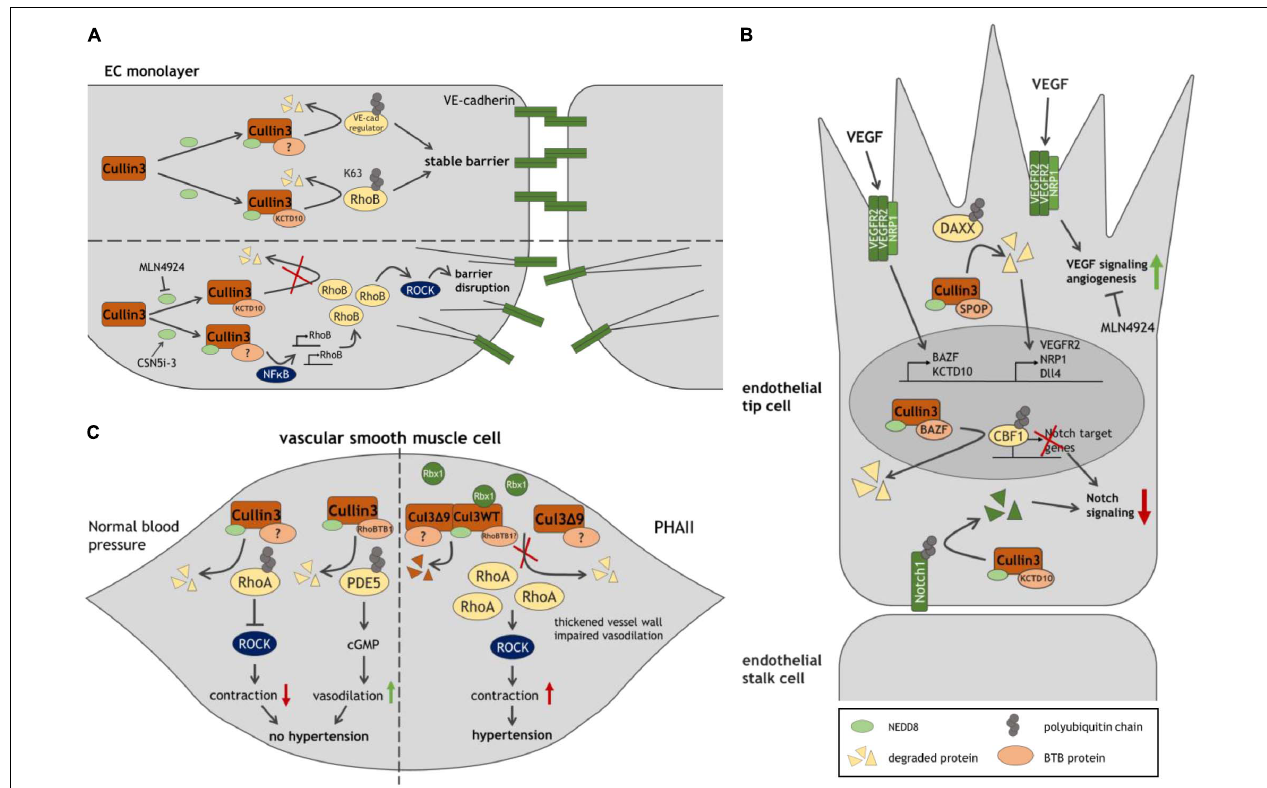
FIGURE 2 | Model of Cullin3 ligases in vascular function. (A) Role of Cullin3 in stable and disrupted endothelial barriers, through its regulation of RhoB-ROCK-mediated contractility. (B) The different functions of Cullin3 ligases in endothelial tip cells, driving angiogenesis. (C) By regulating RhoA- and PDE5-mediated signaling in SMC, Cullin3 controls SMC function and blood pressure. The Cullin3 mutant Cul3 (cid:49) 9 interferes with the regulation of RhoA, resulting in SMC contraction and hypertension. See text and list of abbreviations for